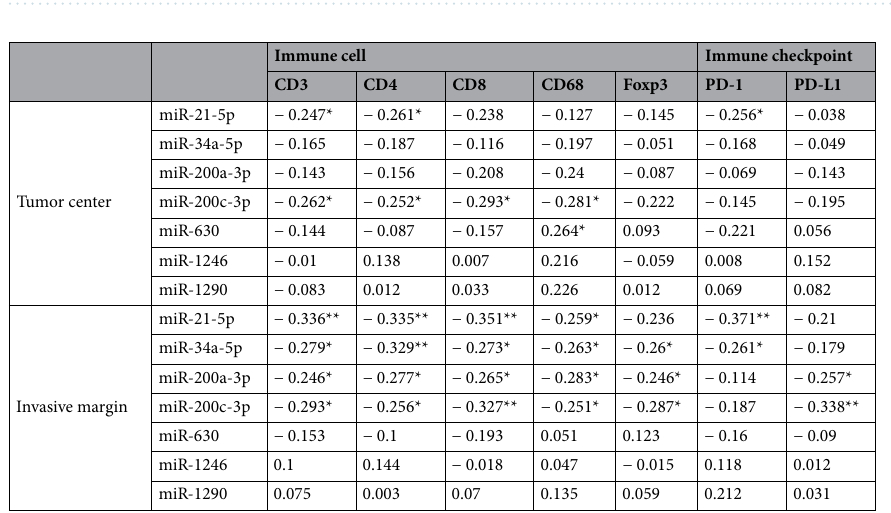
Figure 3. Representative images of immunohistochemistry of EMT markers (ZEB-1 and E-cadherin), immune checkpoints (PD-L1 and PD-1), and immune cell markers (CD3 and CD8) in tumor tissues.